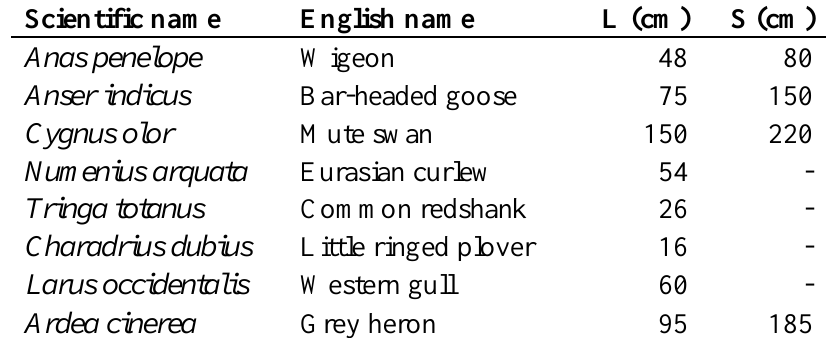
Table 2. Length L and wingspread S [49] of some of the most important hosts of avian influenza according to FAO [12].